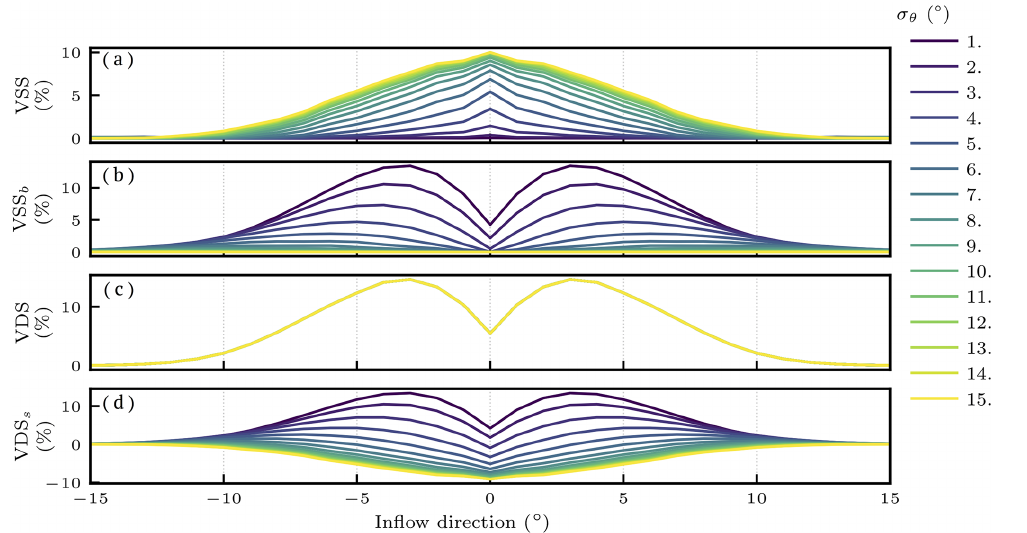
Figure 7. Summary statistics from Table 1 for varying inflow direction θ and uncertainty σ θ in the two-turbine case with 7ms − 1 inflow. Panels show VSS (a) , VSS b (b) , VDS (c) , and VDS s (d) , with different values of σ θ indicated by different line colors (the legend is shown at the right of the